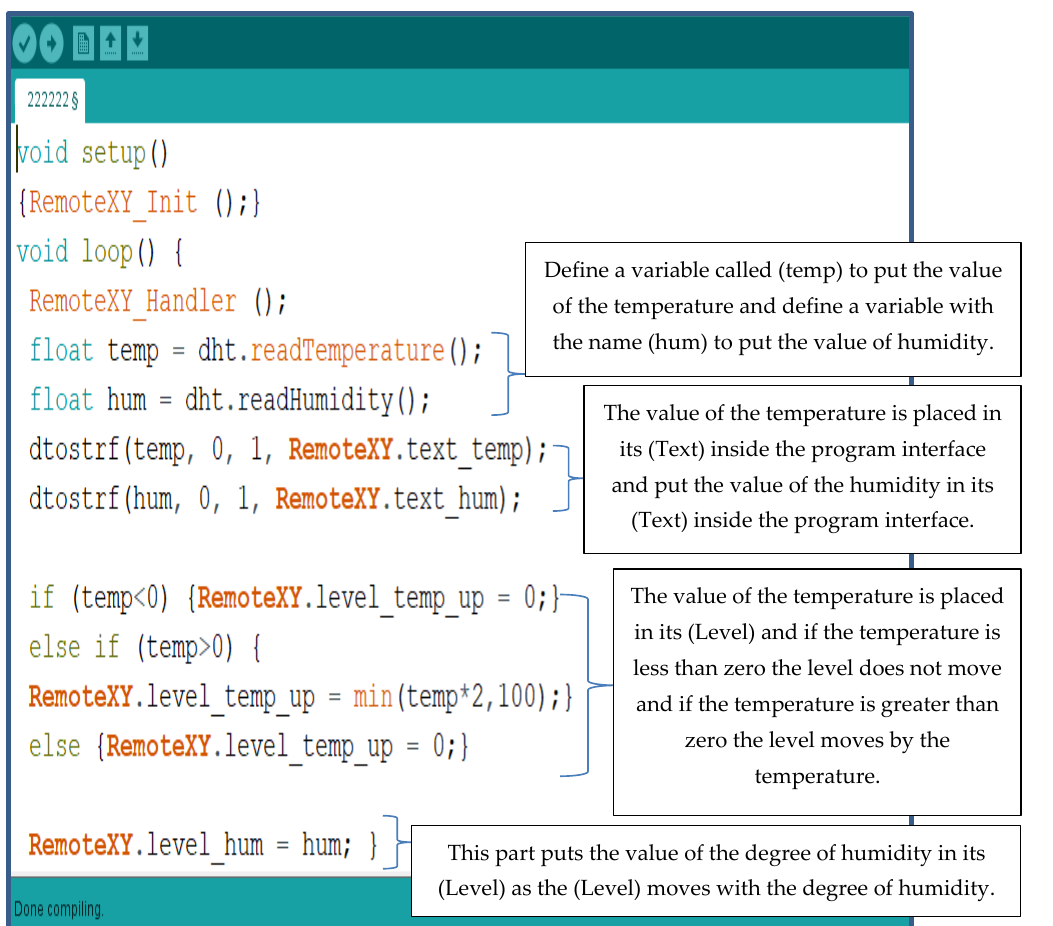
Figure A5. The first part of the executed code used to program the heat and humidity sensor.